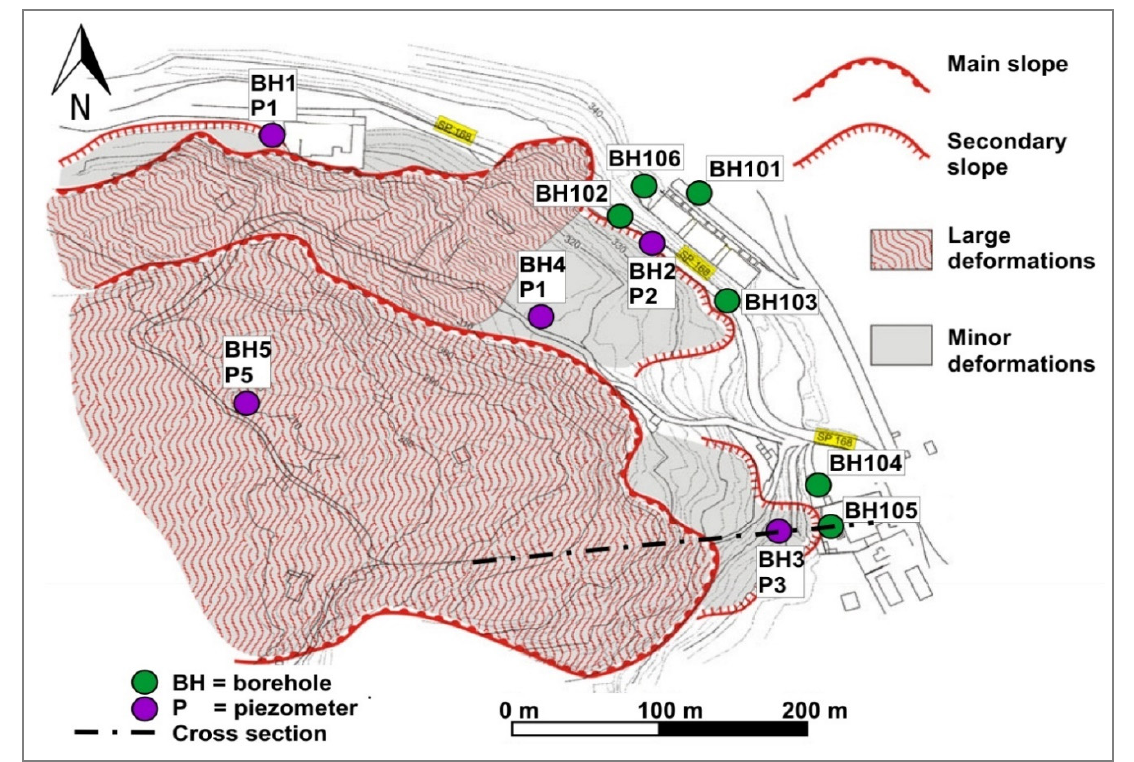
Figure 4. Layout of test sites with the location of geotechnical boreholes and piezometers.